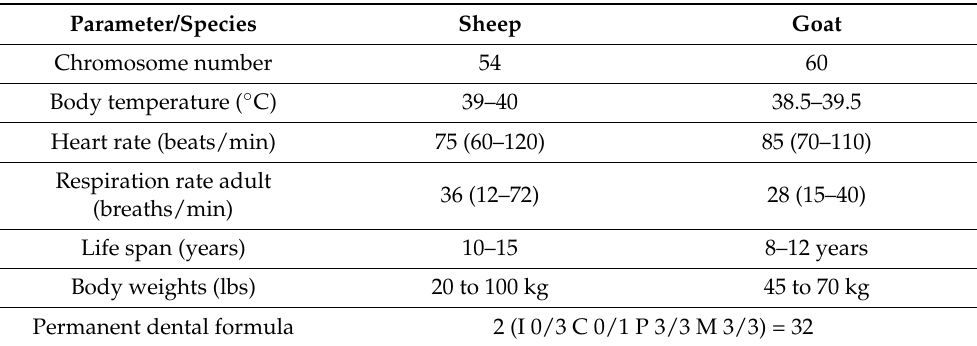
Figure 2. Adult animals (upper panels) and lamb (lower panel) of the species Ovis aries . See Tables 1–3 for physiological and reproductive parameters of both species. Table 1. Normal values of physiological parameters in adult individuals of the species Ovis aries (Sheep) and Capra aegagrus hircus (Goat) (adapted from [1]).